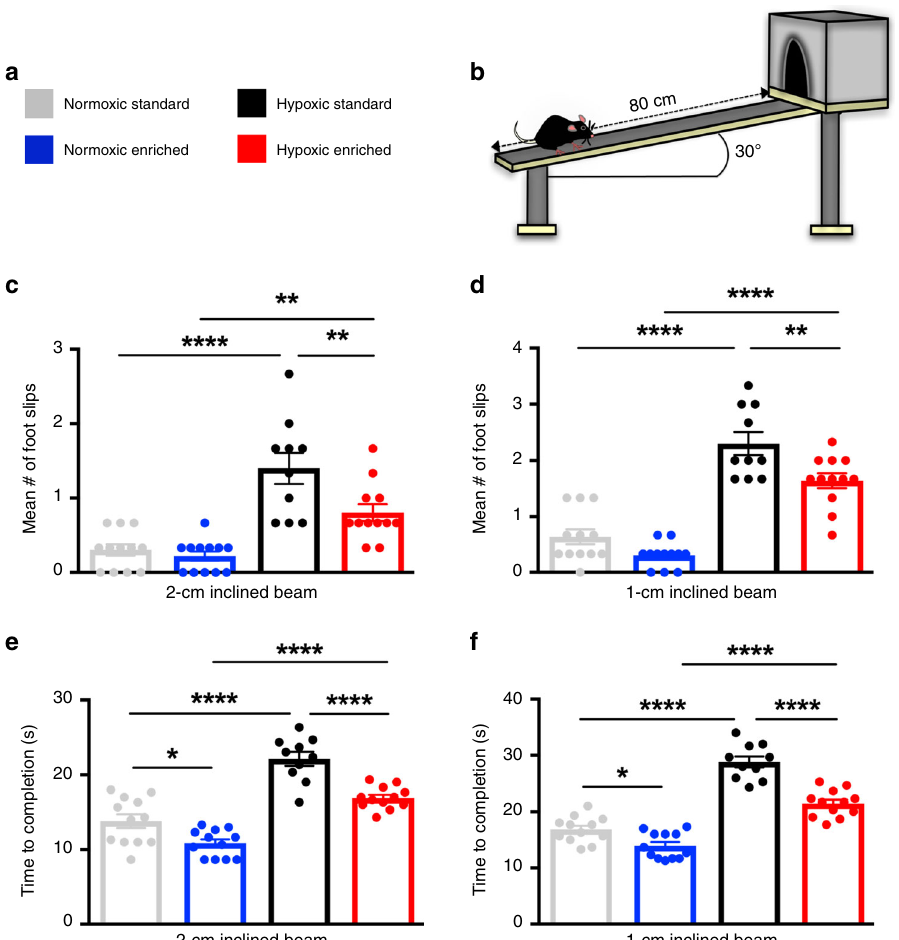
Fig. 3 Environmental enrichment promotes functional recovery after perinatal brain injury. a , b Experimental groups tested on the 2-cm and 1-cm width inclined beam-walking task. c Quanti fi cation of foot slips for the 2-cm beam at P45 (from left to right: **** p < 0.0001, ** p = 0.005, ** p = 0.007) (NX, n